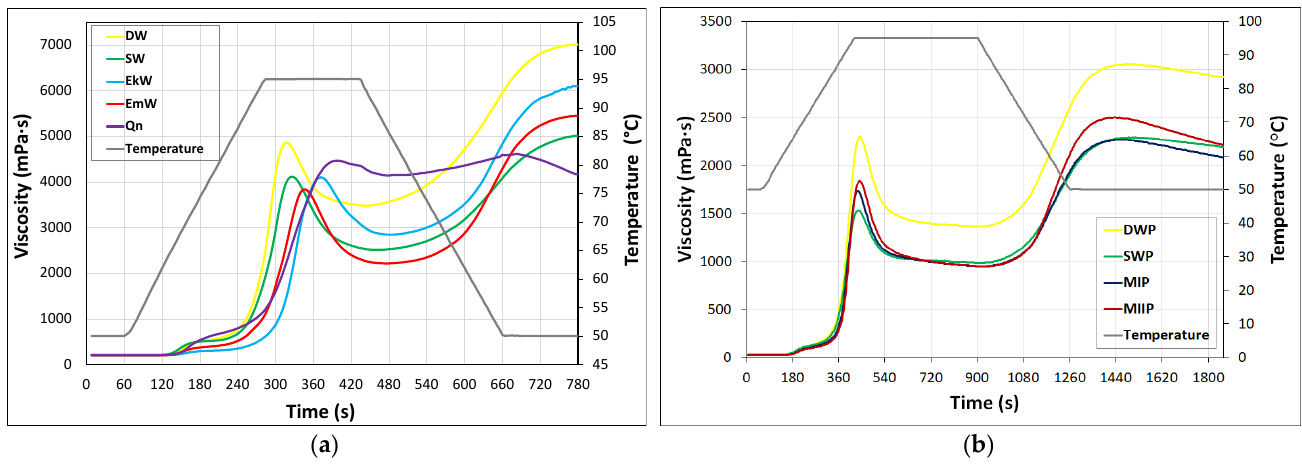
Figure 1. RVA pasting curves of: ( a ) flours; ( b ) raw pasta. The DW flour suspension developed the highest viscosity in the heating phase (PV), while that of the EmW flour developed the lowest viscosity (Table 2). The PV value of the DW flour determined in our study was almost three times higher than that reported by Kamble et al. [42], indicating high ability of the starch contained in the semolina to form a paste on cooking. However, Kaur et al. [43] reported that peak viscosity values of four from thirteen Indian durum wheat varieties measured at a concentration of 10% ranged from 893 to 2469 cP; therefore, it is evident that this pasting parameter is strongly dependent on the grain variety. In the literature, there is no data available on the pasting parameters of emmer wheat flour determined by the RVA technique. The extent of lowering of the viscosity of the systems after reaching the PV, calculated as BD × 100/PV, was relatively the largest in the case of the EmW flour (approx. 42%), lower in the SW flour (approx. 39%), followed by the EkW (approx. 31%), and DW (approx. 28%) flours, and the lowest was in the case of the Qn flour (approx. 7%). These data indicate a relatively high sensitivity of the pastes of the flours produced from the ancient wheat varieties to high temperature and mechanical treatments. The DW flour system reached the highest FV among the tested flours, while the Qn paste turned out to be the least viscous (Table 2). The reason for the lower viscosity of the systems of the flours from ancient wheat varieties than that of the durum wheat semolina might be explained by